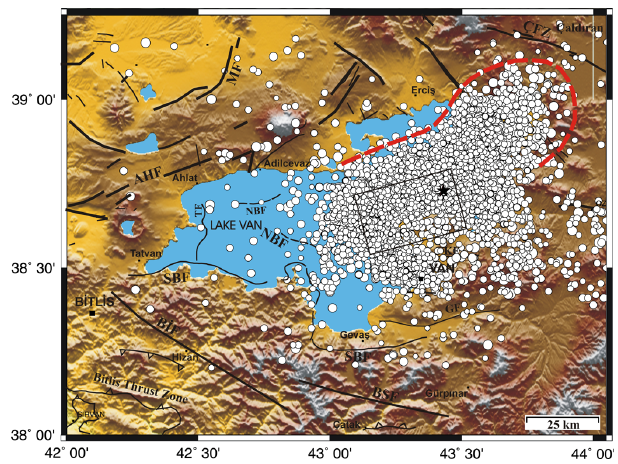
Fig. 4. Epicentre distribution of the aftershocks (white filled circles) occurred until April 2012 and provided by Kandilli Observatory and Earthquake Research Institute along with local tectonic features. The black star and the rectangle denote the epicentre and surface projection of the rupture plane of the 2011 Van earthquake used by Utkucu (2013a), respectively. Note that the dense aftershock epi- centres cover much broader area toward NE due to a lobe of after- shock epicentres (broken red line) protruding outward. See caption of Fig. 2 for the active fault references and abbreviations and text for